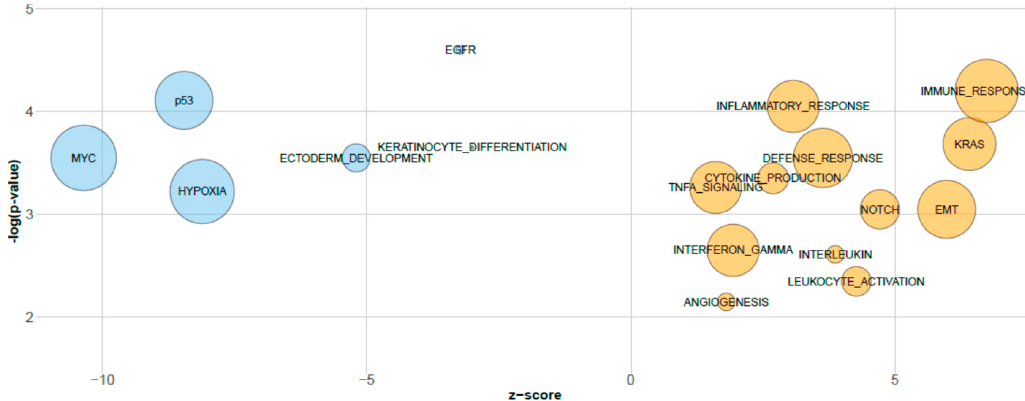
Figure 2. Bubble plot of gene sets associated with miRNAs’ first and second components identified by sPLS-DA: An overview of GSEA-enriched networks was depicted. The x-axis indicates the z-score for each term, while the y-axis is the negative logarithm of the adjusted p -value. The area of the displayed circles is proportional to the number of genes assigned to each term. The colors display the positive association to the first (blue) and second (orange) components.